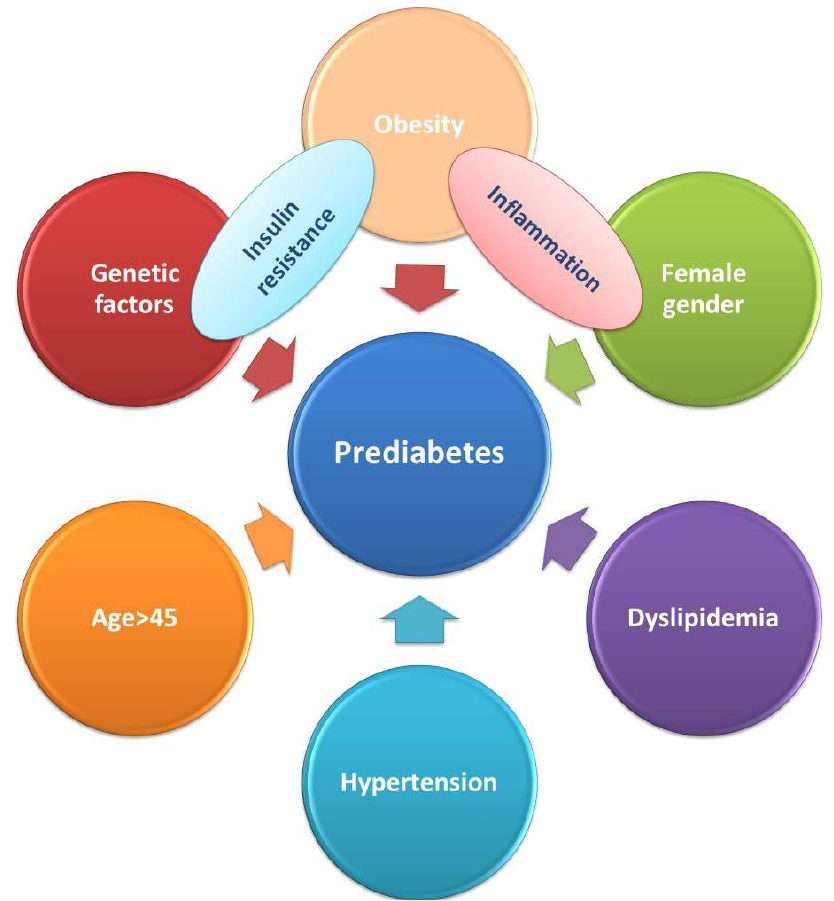
Figure 1. Risk factors associated with